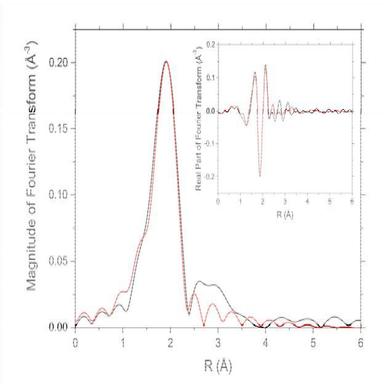
XAFS difference spectrum for sulfided 5% Mo/Al2O3 catalyst. The plot shows the magnitude of c(R) representing the difference in the radial function before and after mild reduction to 250 °C in H2/argon gas blend. Modeled spectrum is in red.